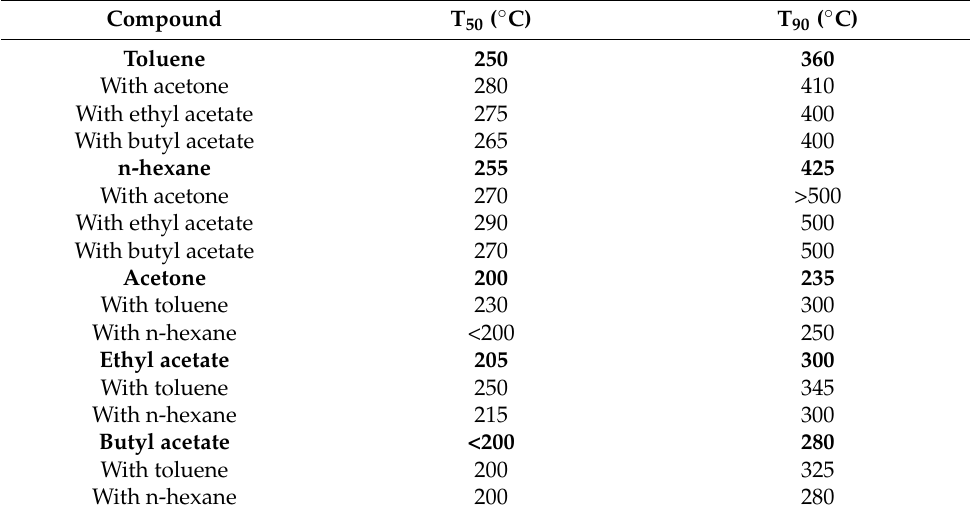
Table 2. Temperature ( ◦ C) of 50% and 90% conversion efficiencies of selected compounds oxidized individually and in the mixtures, data from